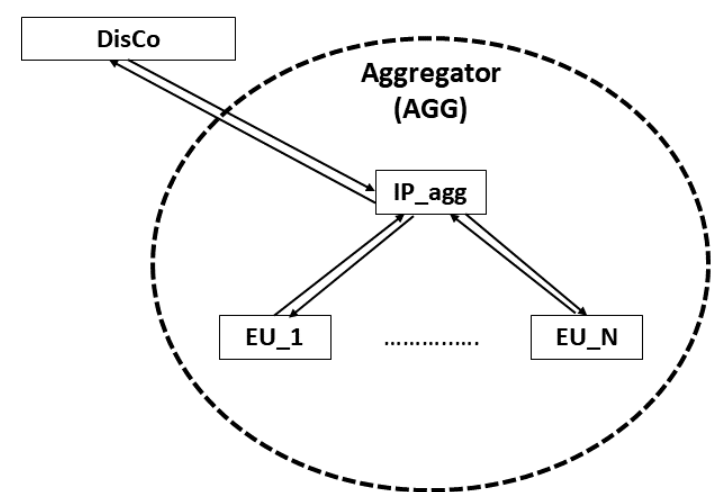
Figure 2. Organization of aggregator